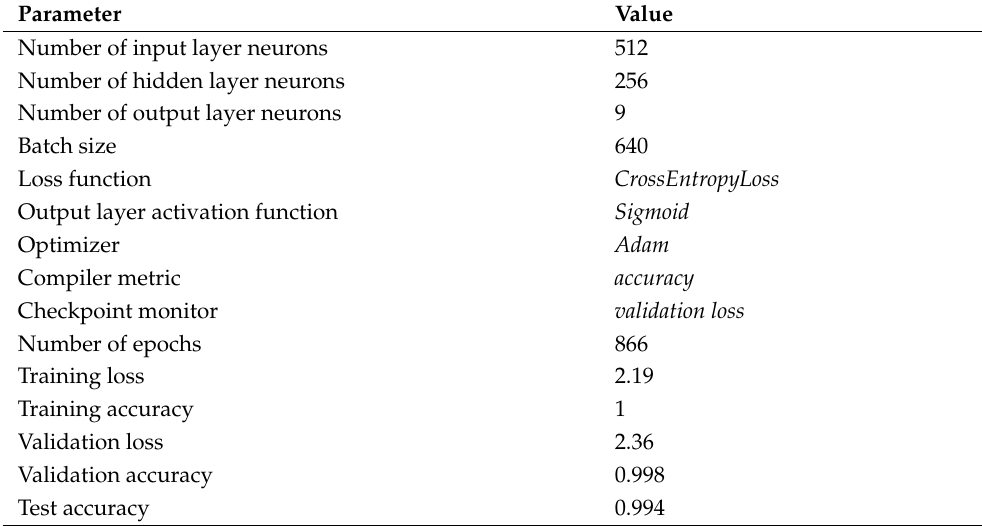
Table 4. Parameters of the selected LSTM-based fault classifier.